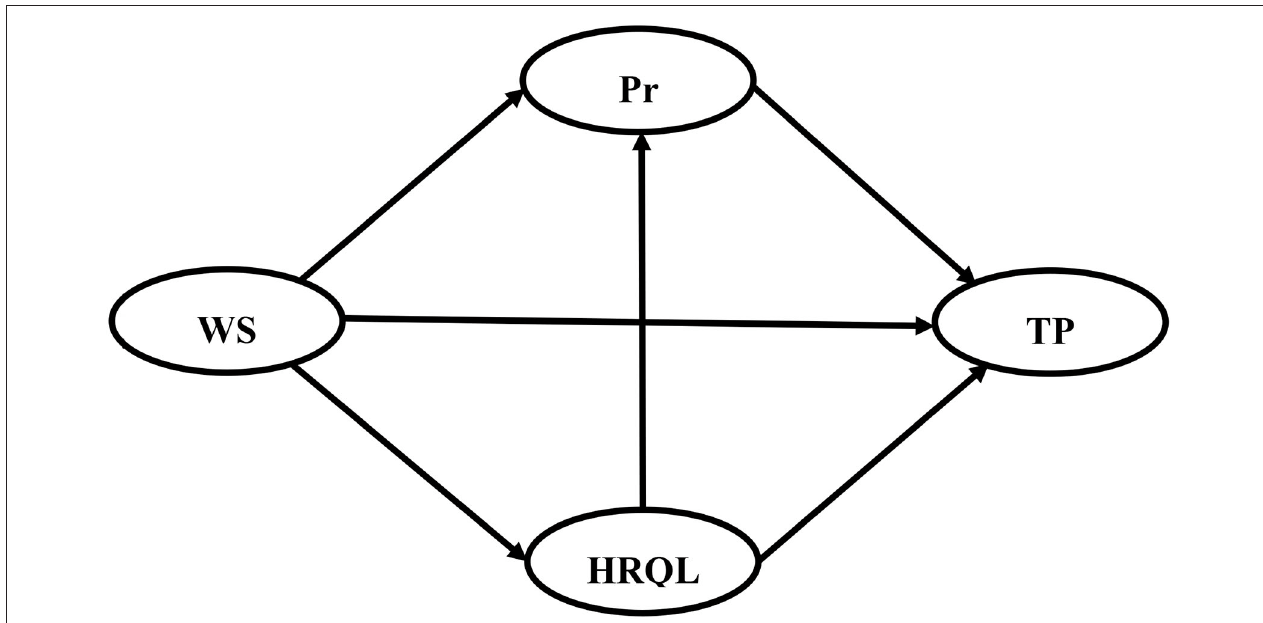
FIGURE 1 | The hypothetical structural equation model. TP, task performance; WS, work stress; HRQL, health-related quality of life; Pr,